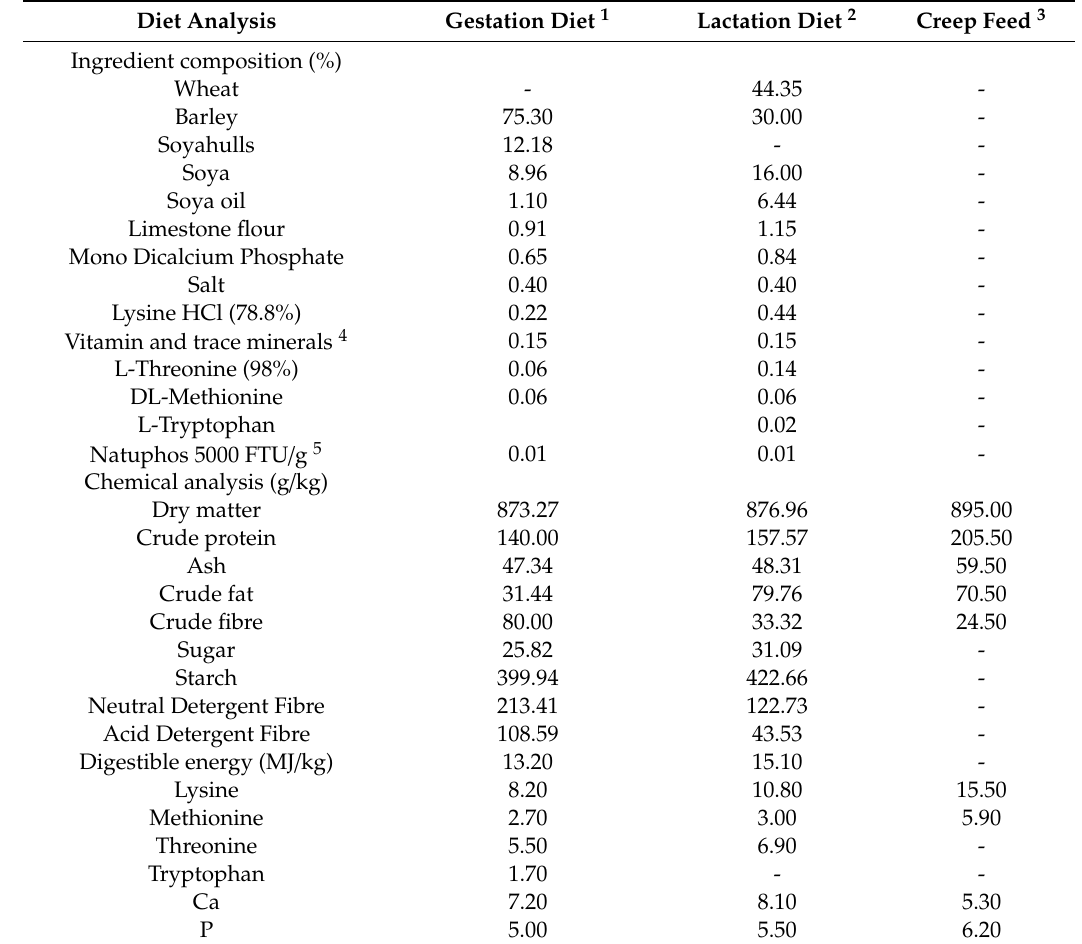
Table 1. Ingredient composition and chemical analysis of sows’ gestation and lactation diets and piglets’ creep